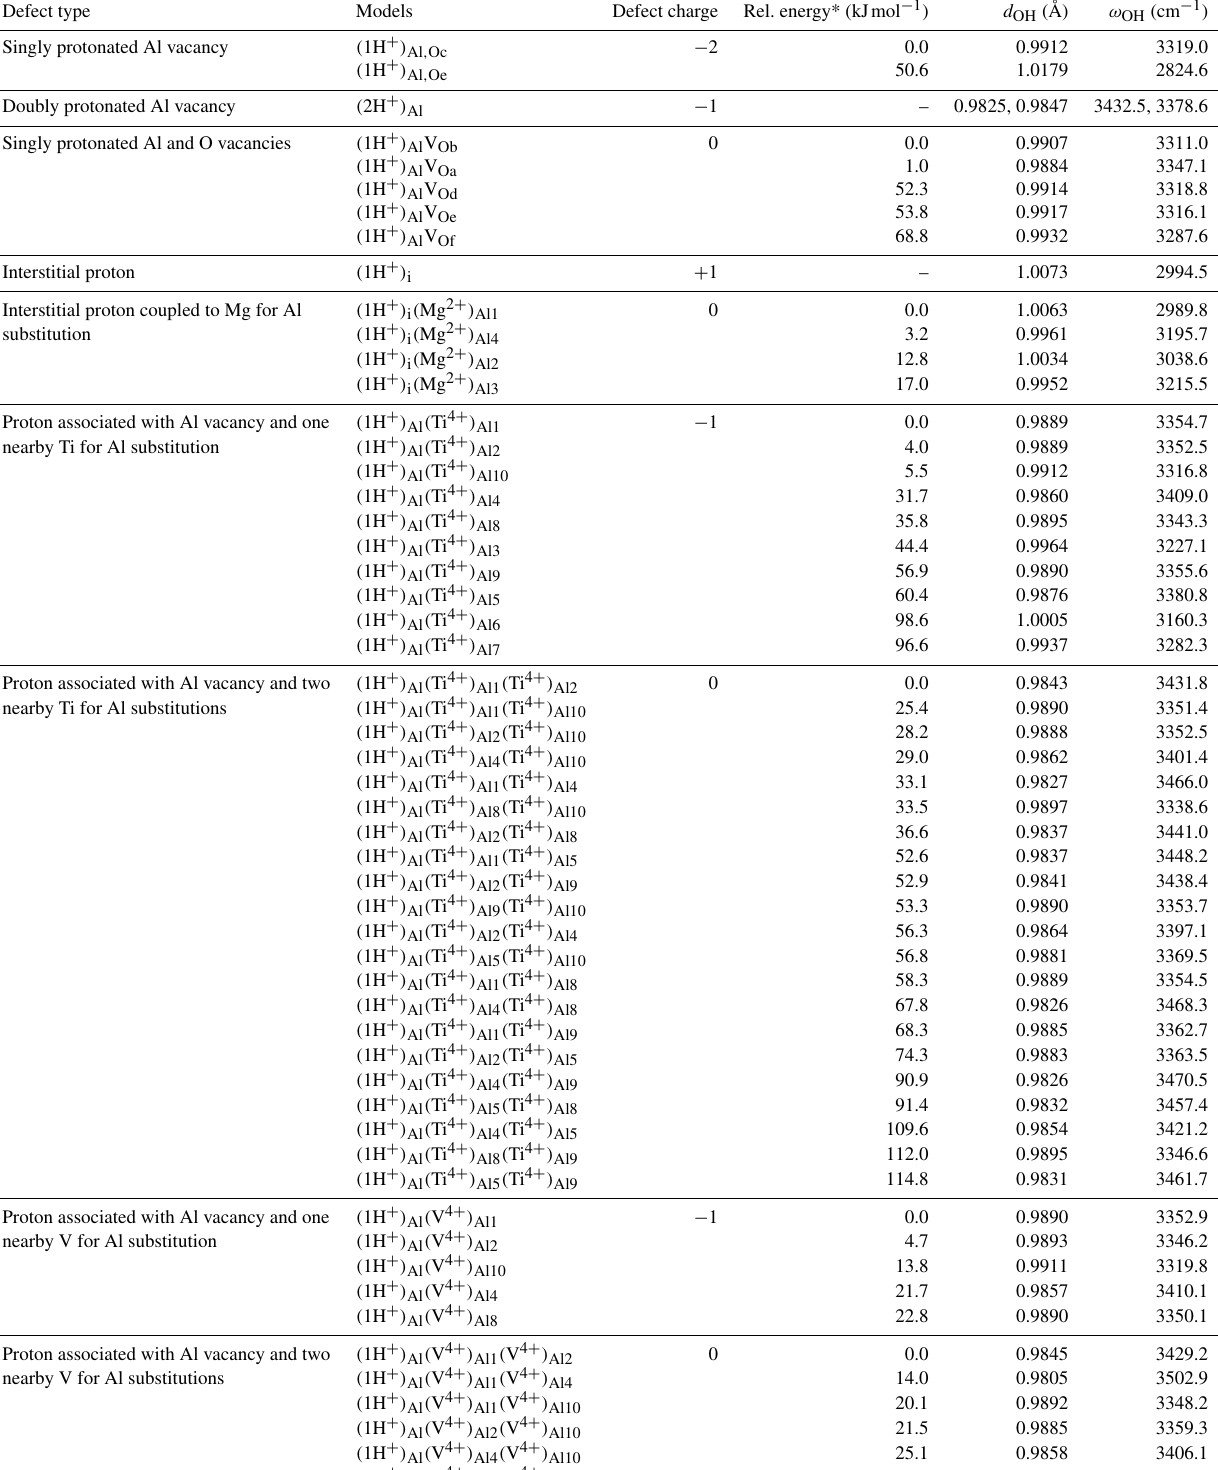
Table 1. Structural, energetic and vibrational properties of OH defects in corundum (structure files are provided in the Supplement). Defect